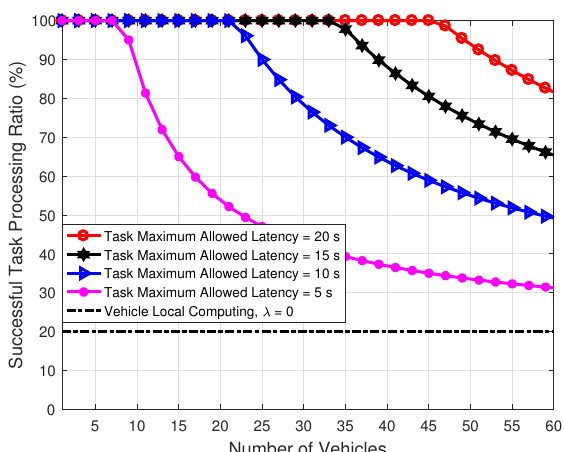
Figure 13. Comparison of the successful task processing ratio with respect to the number of vehicles under different task maximum allowed